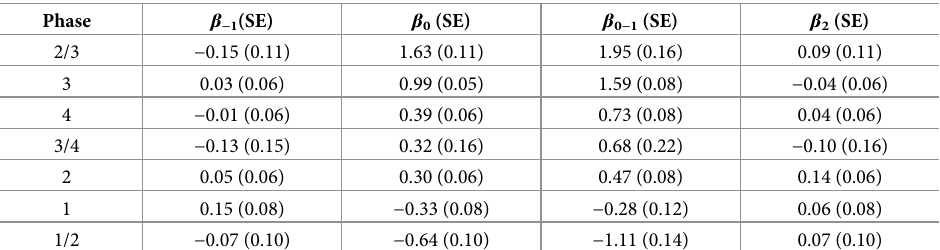
Table 5. Phase categories.